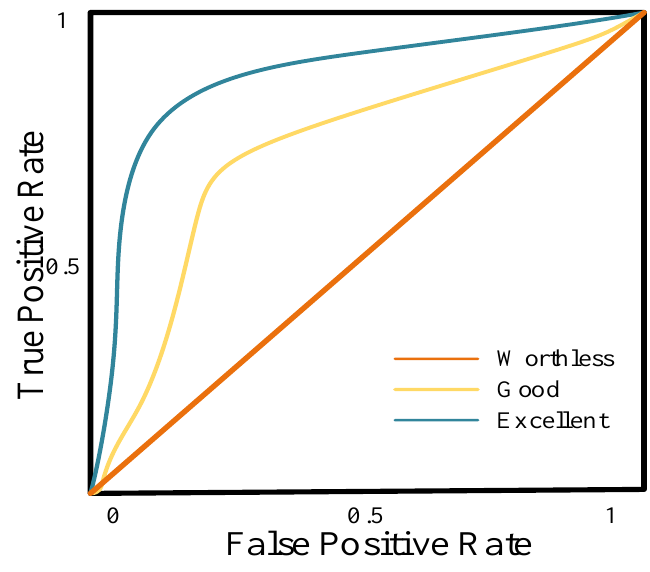
Figure 5. ROC curve [30].